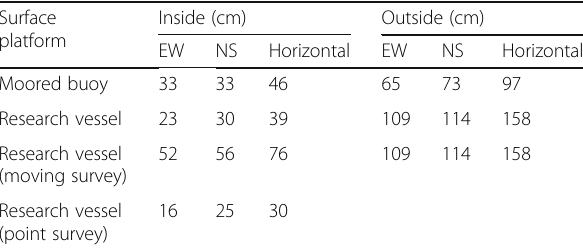
Table 2 Accuracy of array